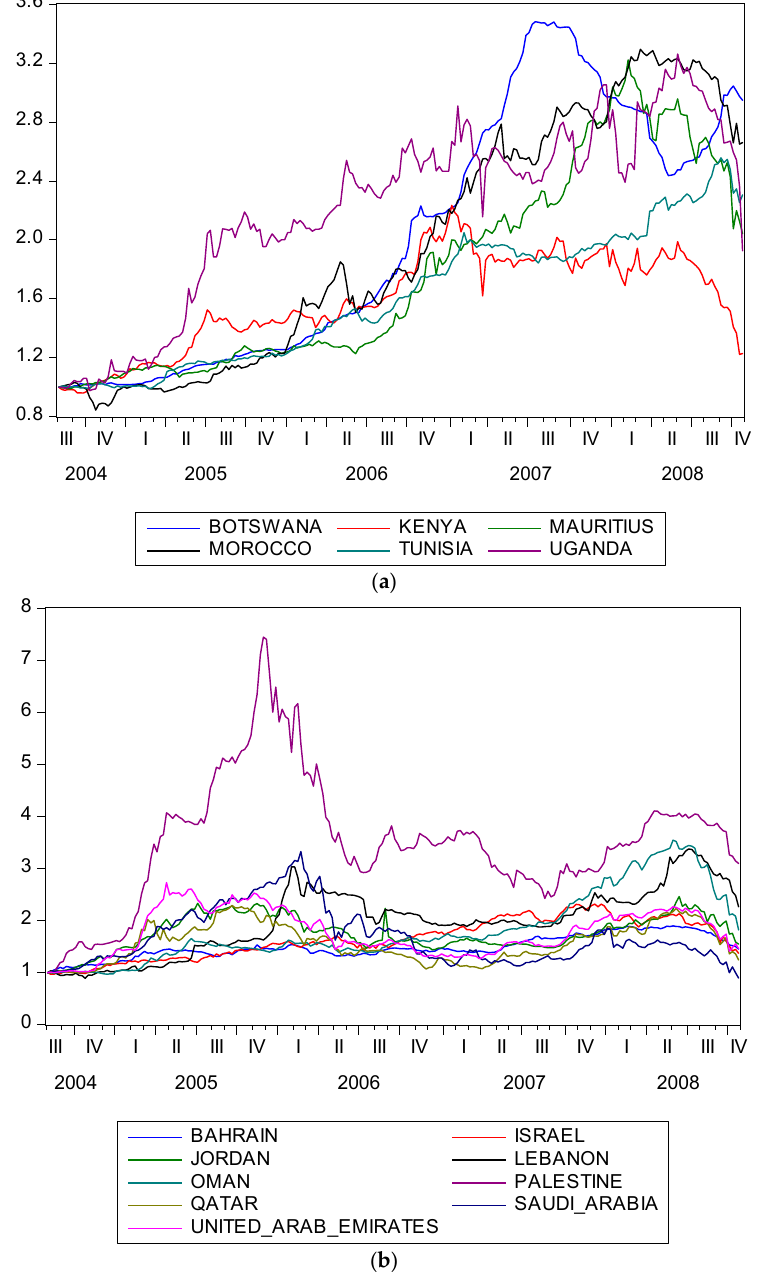
Figure 2. ( a ) African stock indices in the pre-QE period; ( b ) Middle Eastern stock indices in the pre-QE